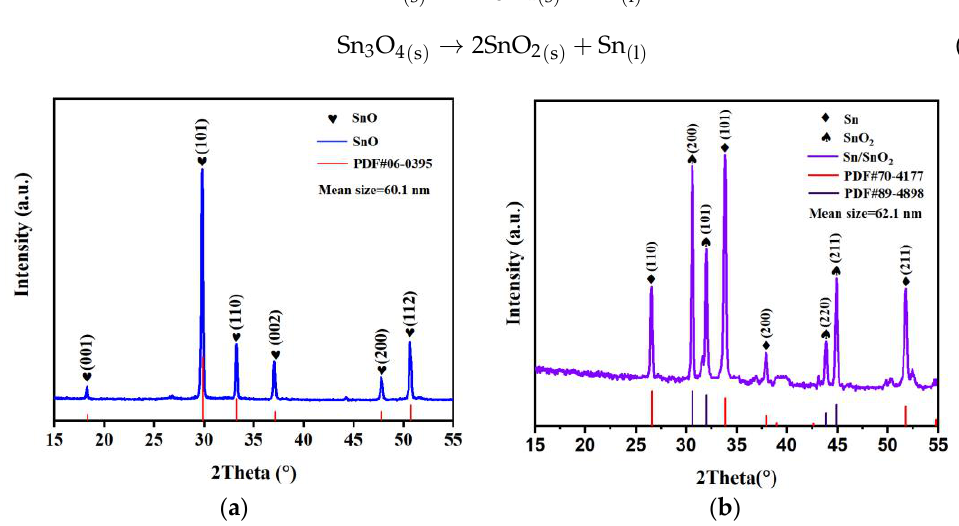
Figure 3. XRD patterns of ( a ) SnO precursor; ( b ) Sn/SnO 2 .